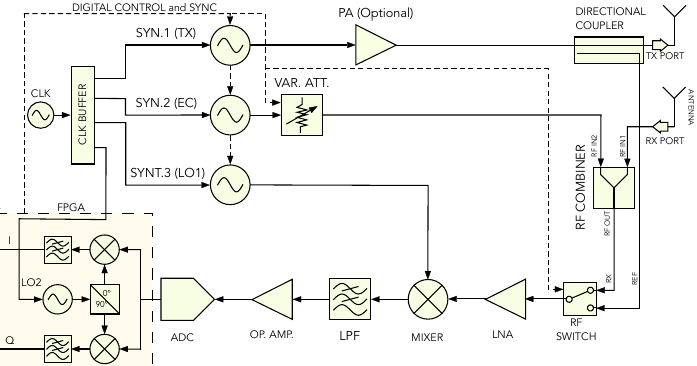
Figure 2. Block diagram of the proposed super-heterodyne architecture SFCW radar with integrated EC